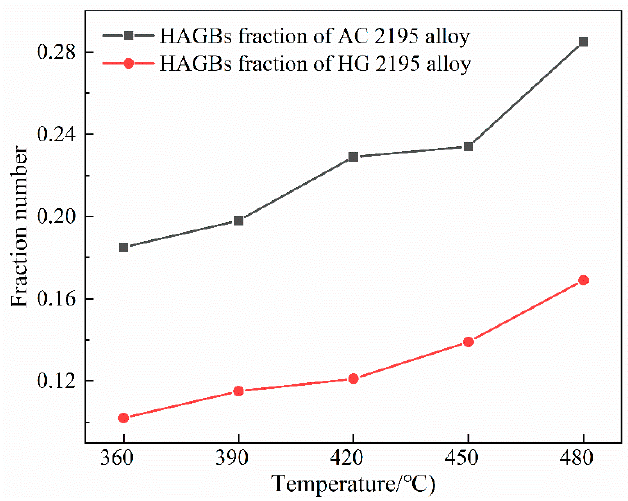
Figure 12. The fraction of HAGBs for AC and HG AA2195 alloy under different deformation conditions.